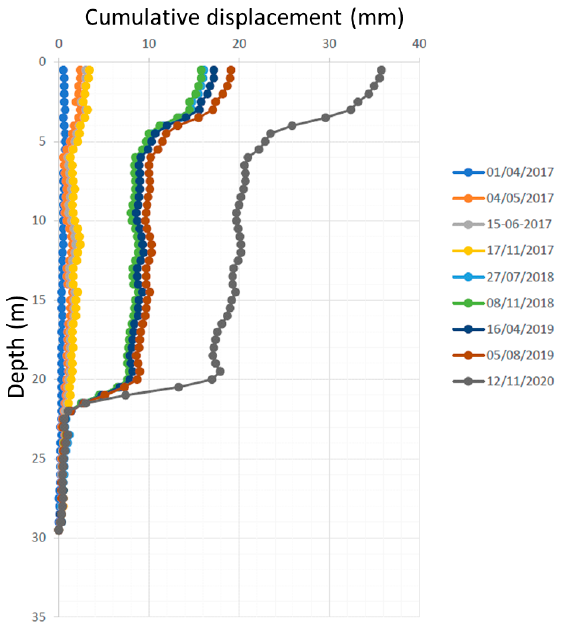
Figure 9. Inclinometer measurements.